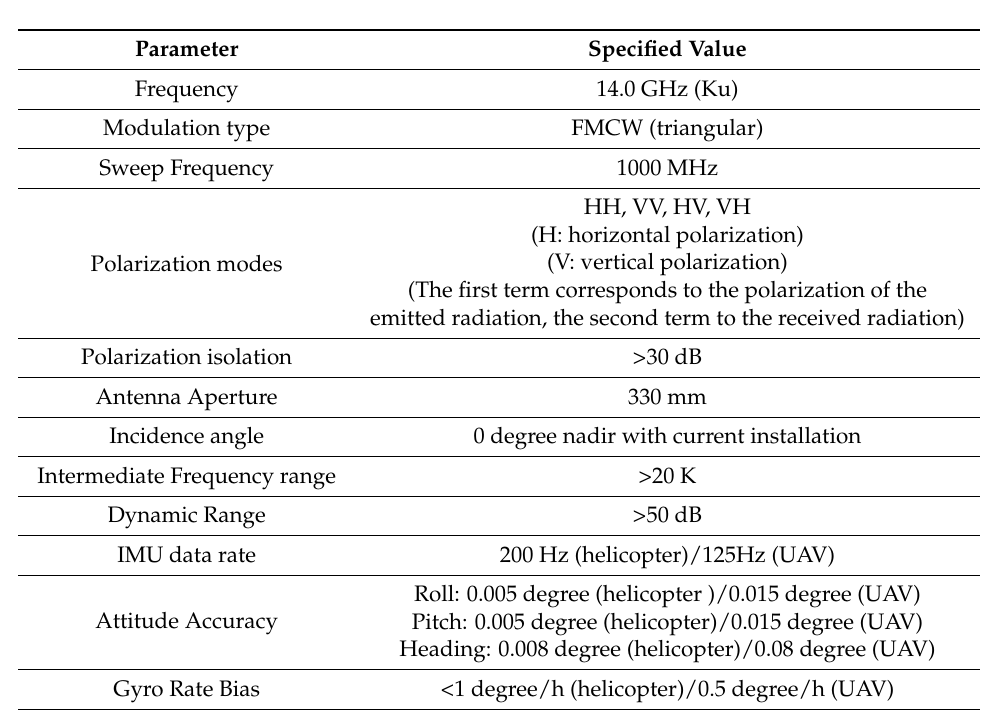
Table 2. Technical Characteristics of